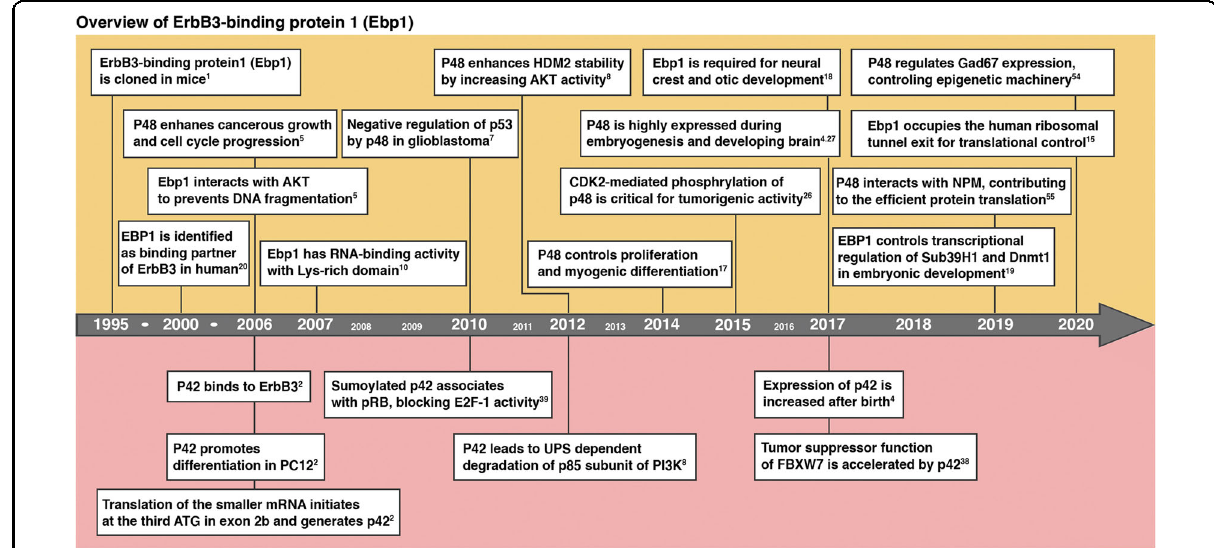
Fig. 1 Overview of ErbB3-binding protein 1. Murine p38-2G4, a homolog of human ErbB3-binding protein 1 (EBP1, PA2G4), was originally identi fi ed as a cell cycle-speci fi cally modi fi ed and proliferation-associated nuclear protein in 1995, and it has been well de fi ned for its novel function over two decades. The upper panel shows the fi ndings for p48 EBP1, and the lower panel shows the fi ndings for p42